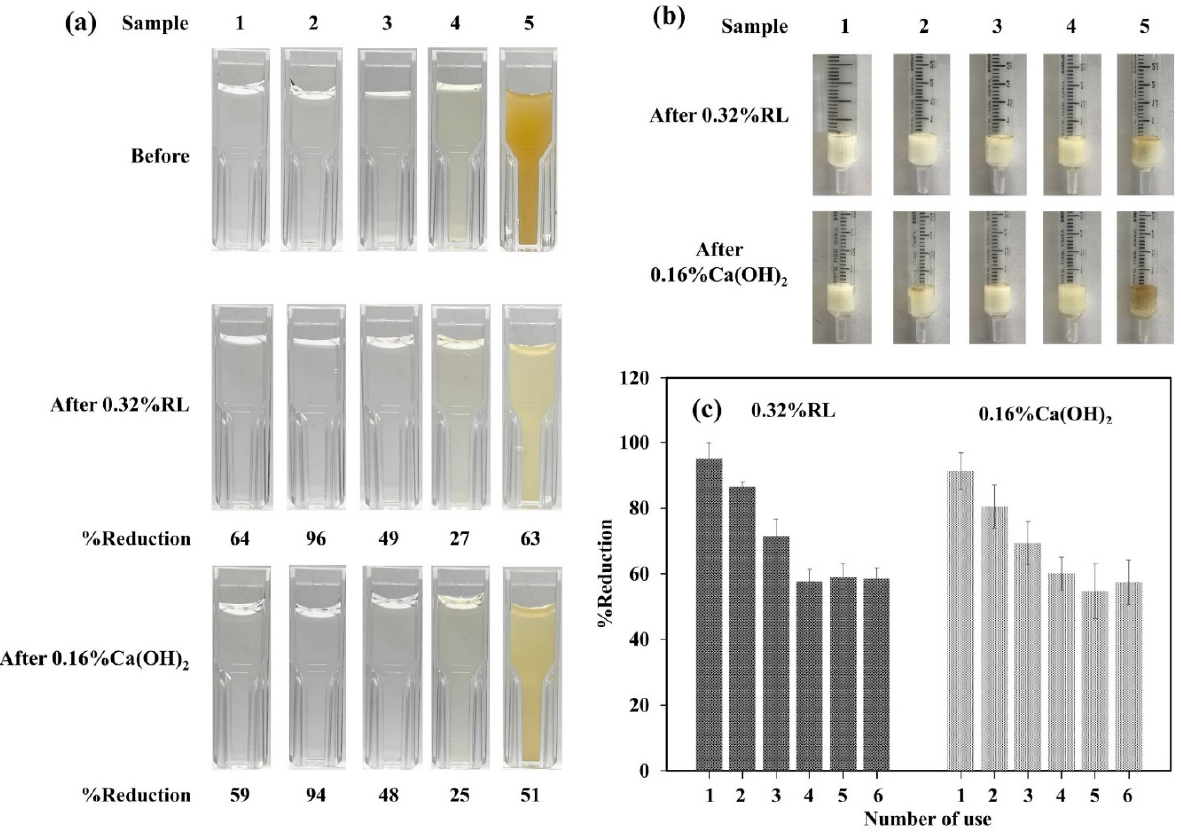
Figure 8. ( a ) Real water samples before and after filtering through the cryogels; ( b ) the cryogels after used to filter real samples; ( c ) reusability of the filters.